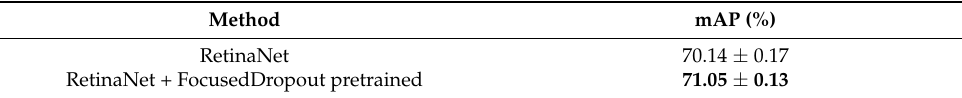
Table 4. The performance comparison on Pascal VOC dataset.